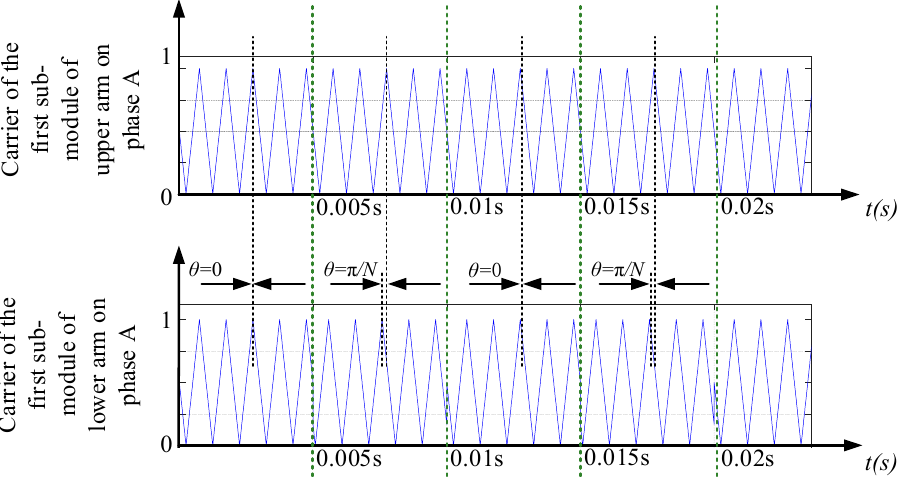
Figure 4. Comparison diagram of upper- and lower-arm carriers when SDA-based CPS modulation is adopted.